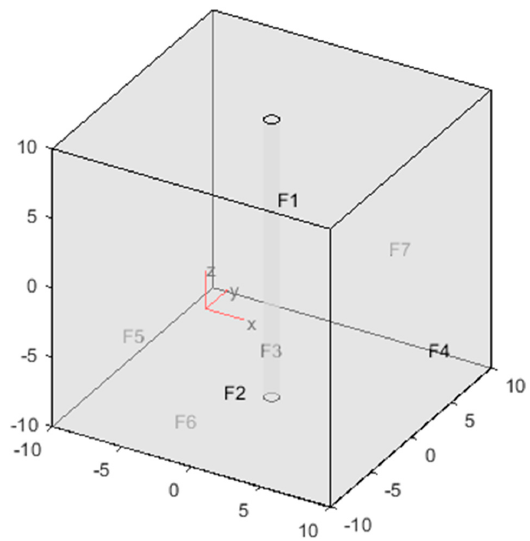
Figure 5. Wellbore-centric computational volume data cube 161 nodes on a side for node spacing ~12 cm. A 30 cm radius wellbore is denoted by shaded vertical shaft with interior surface face F3. External boundary faces are F1–F2 and F4–F7. Pressure, temperature, and/or flux boundary conditions at faces F1–F7 define the steady-state flow/advection simulation performed by Matlab finite-element solvers (6) and (7).